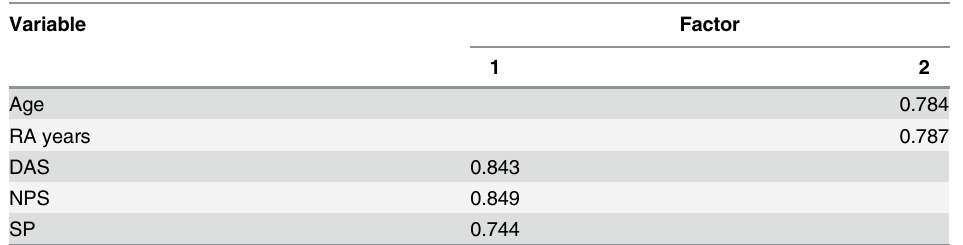
Table 3. Factor analyses on SP, NPS, DAS, age and RA years ’ disease.